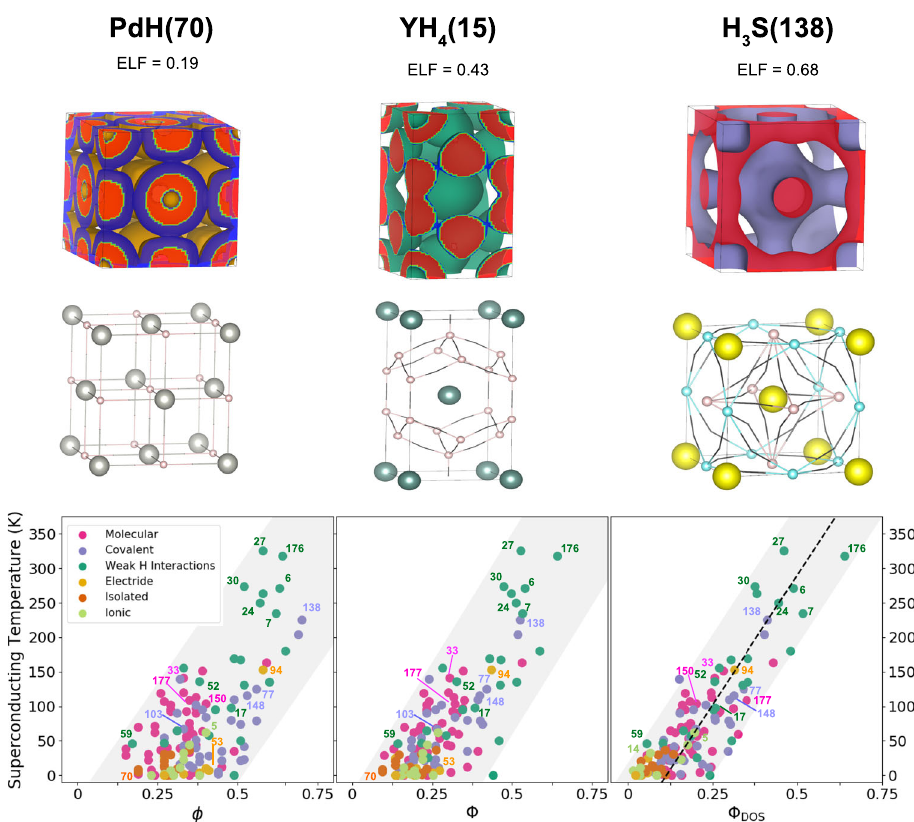
Fig. 4 Networking value. The upper panel shows the ELF isosurface and the three dimensional network spanning through all the crystal, which is formed by the ELF saddle points and the atoms, associated with the ϕ value for PdH(70), YH 4 (15), and H 3 S(138). The networking value is given for each case. The bottom panels show the critical temperature T c as a function of the networking value ϕ (left), the networking value multiplied by H f (center), Φ = ϕ H f , and the networking value multiplied by H f and the cubic root of the fraction of the DOS at the Fermi energy coming from the hydrogen atoms H DOS , ffiffiffiffiffiffiffiffiffiffi p Φ ¼ ϕ H H (right). The dotted line in the last panel represents a fi t for which T c = (750 Φ DOS − 85) K which is able to estimate T c within 60 f DOS DOS 3